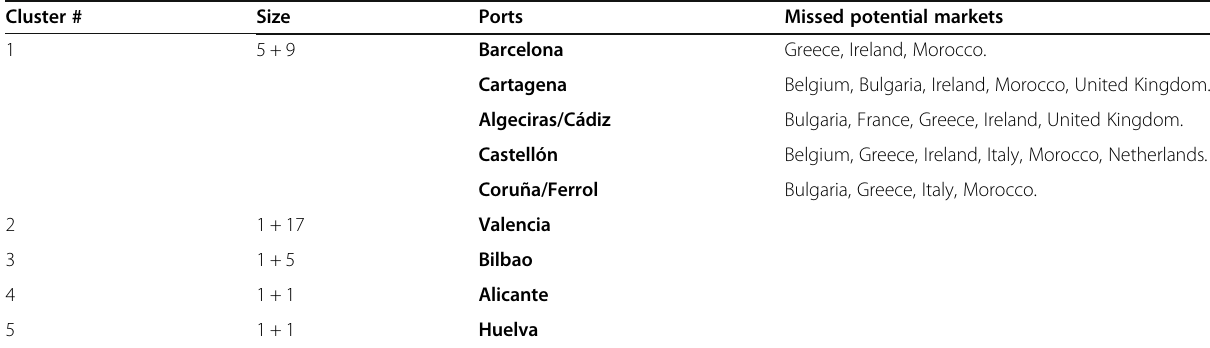
Table 5 Communities and link prediction for “ Biofuels ” export graph, in 2019. Size means number of ports + number of countries in the